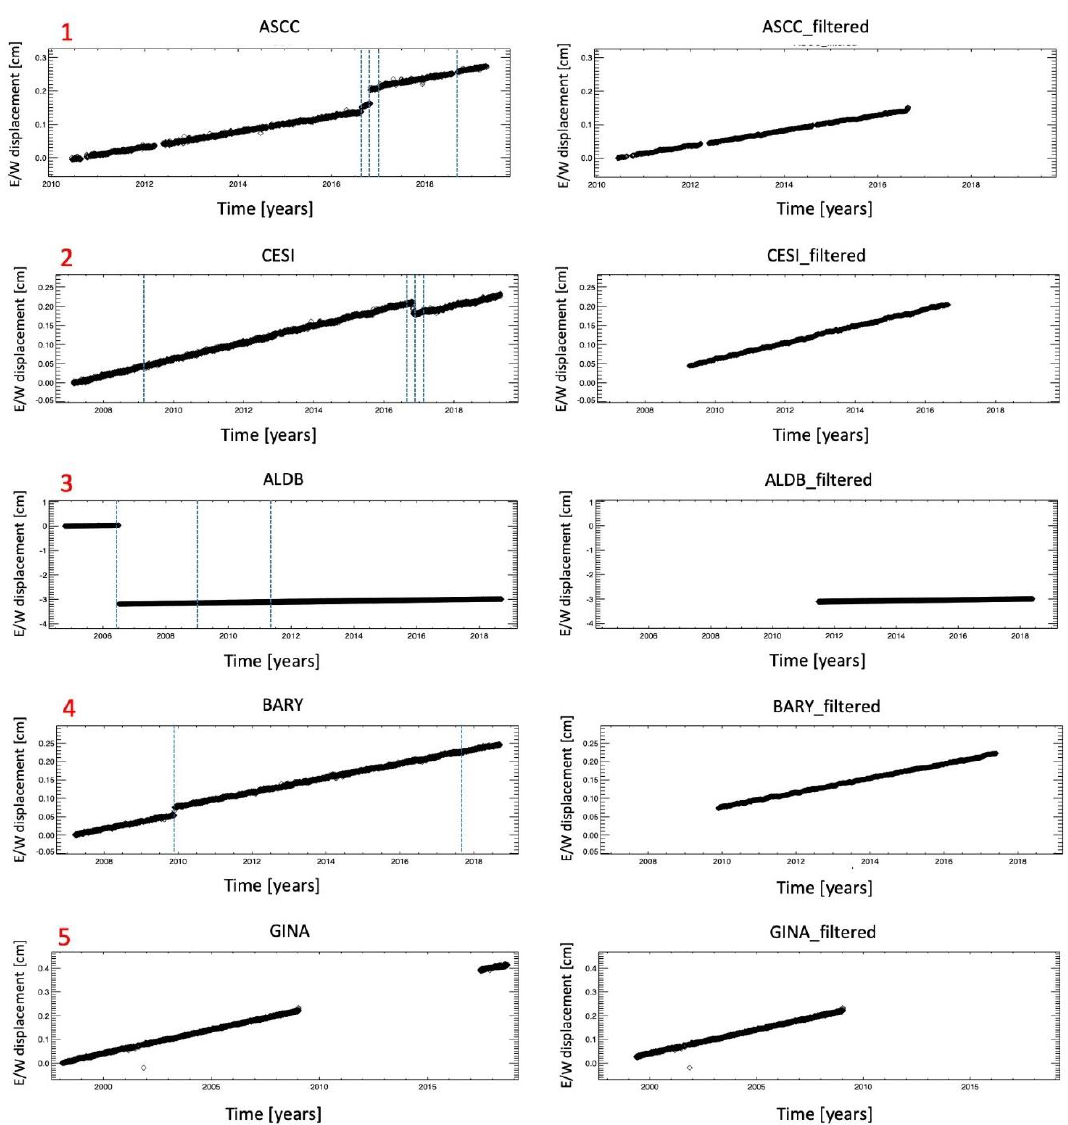
Figure 4. Examples of the GNSS stations position time series screening operation. Plots (1)–(5) are relevant to the five GNSS stations named ASCC, CESI, ALDB, BARY and GINA, respectively. On the left side the original time series (East-West component) are shown, while on the right side there are the corresponding ones following the data screening procedure. The dashed blue vertical lines identify the dates for which the GNSS auxiliary files report the presence of gaps and/or steps in the time series.